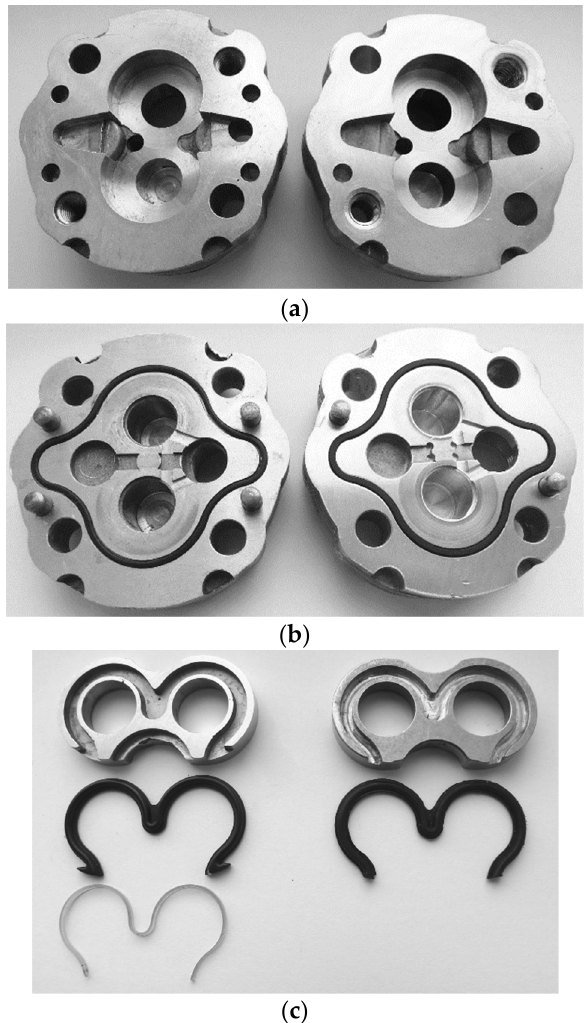
Figure 5. Two variants of ( a ) pump body, ( b ) cover and ( c ) compensator. For each subfigure, the left side shows the new proposed solutions of the pump com- ponents, while the right side corresponds to the previous solutions, following the param- eterization and design processes. Both solutions are still in production and testing stages.